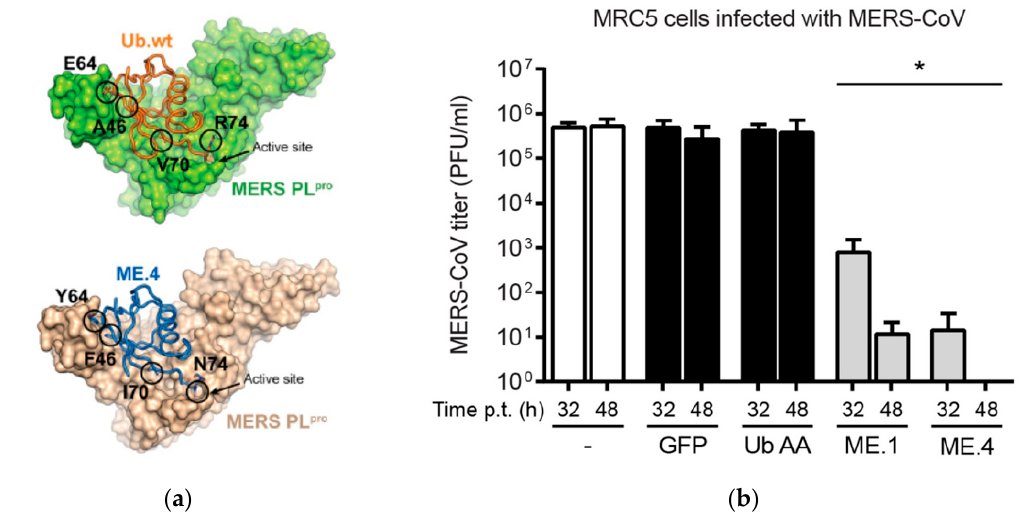
Figure 4. Synthetic ubiquitin variant (UbV) block MERS virus infection in a human cell line [119]. ( a ) MERS PLpro in complex with wild type ubiquitin or the inhibitory ubiquitin variant ME4. ( b ) UbV ME4 leads to drastic reduction in virus titer in MRC5 cells infected with MERS-CoV.7. Future Research against COVID-19.